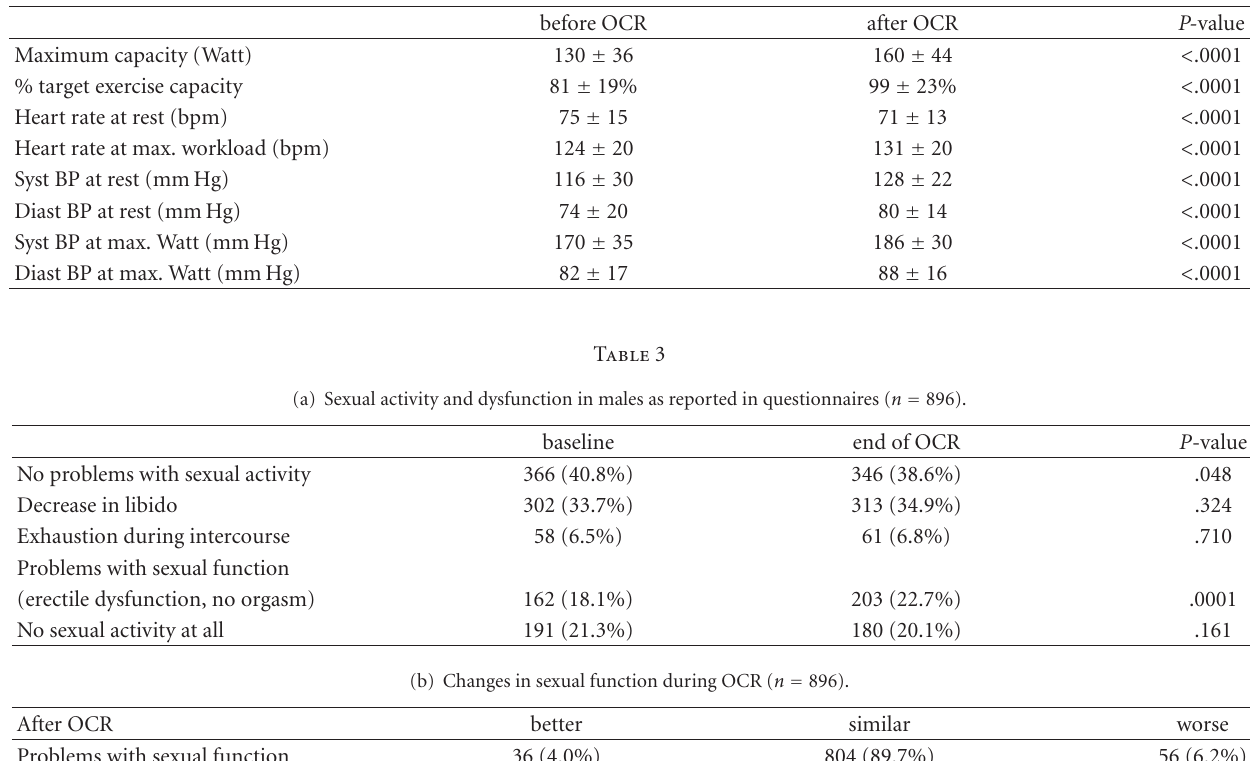
Table 2: Exercise test results at baseline and at end of OCR ( n = 896).